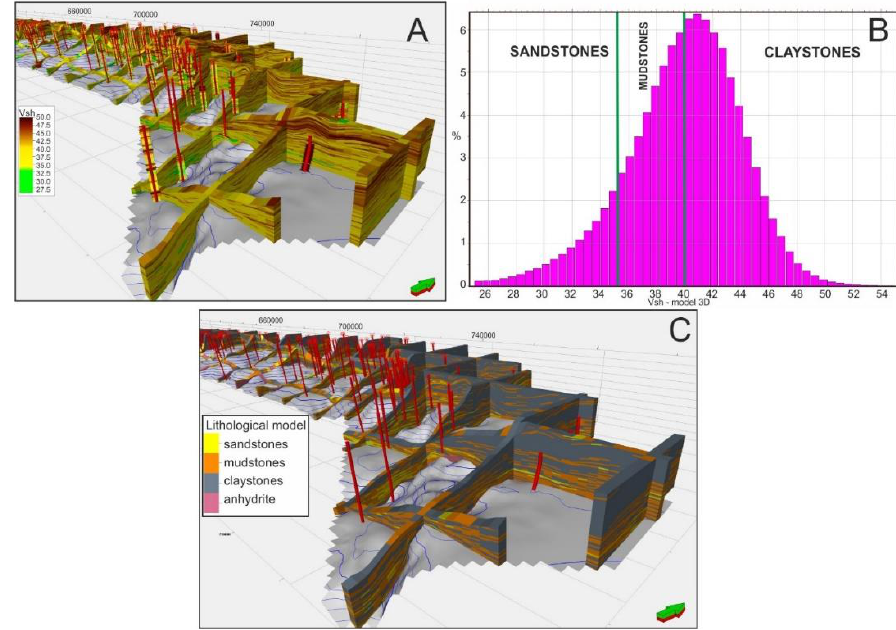
Figure 6. Three-dimensional model of clay content converted to lithofacies 3D distribution implemented in petroleum system model: ( A ) 3D model of clay volume; ( B ) histogram of clay content values divided into three lithological categories: Sandstones, mudstones, and claystones; ( C ) 3D distribution of lithological types applied in petroleum system simulations.